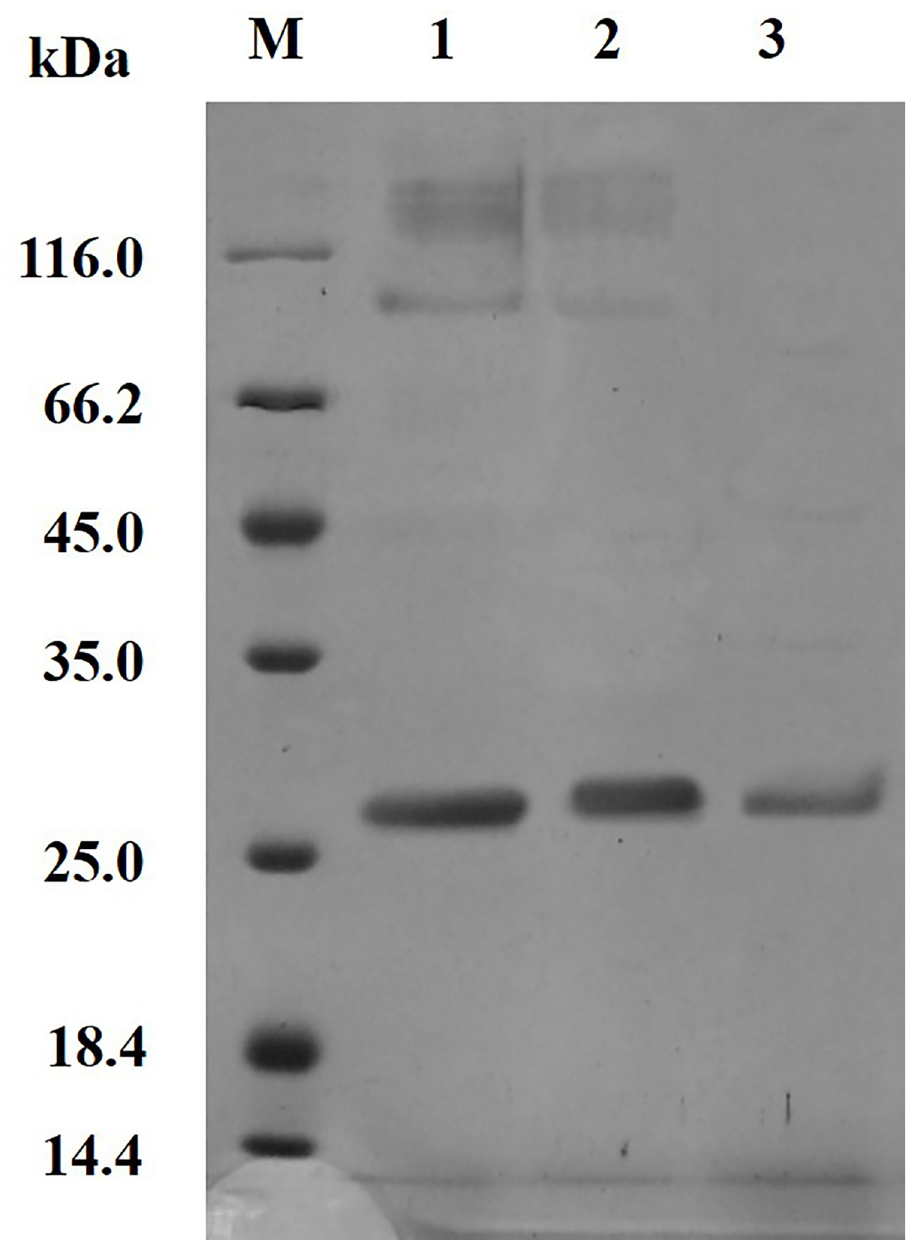
Fig 4. SDS-PAGE analysis of the purification of recombinant protease HypZn. M: Protein molecular weight standard; 1: Crude enzyme solution; 2: Enzyme liquid precipitated by ammonium sulfate; 3: Enzyme solution purified by chromatographic column